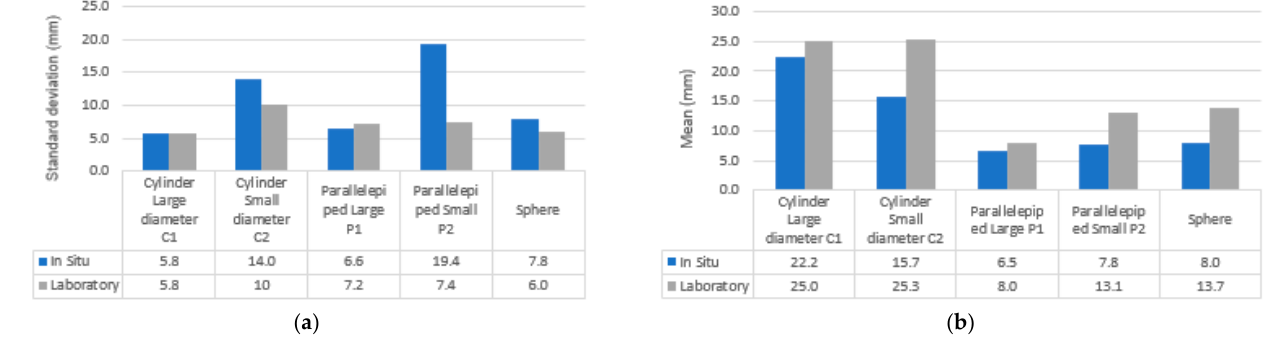
Figure 14. Comparison in situ vs Labo of LiDAR smartphone data on geometric primitives: ( a ) for standard deviation Cloud to primitive; ( b ) for the mean distance Cloud to primitive.